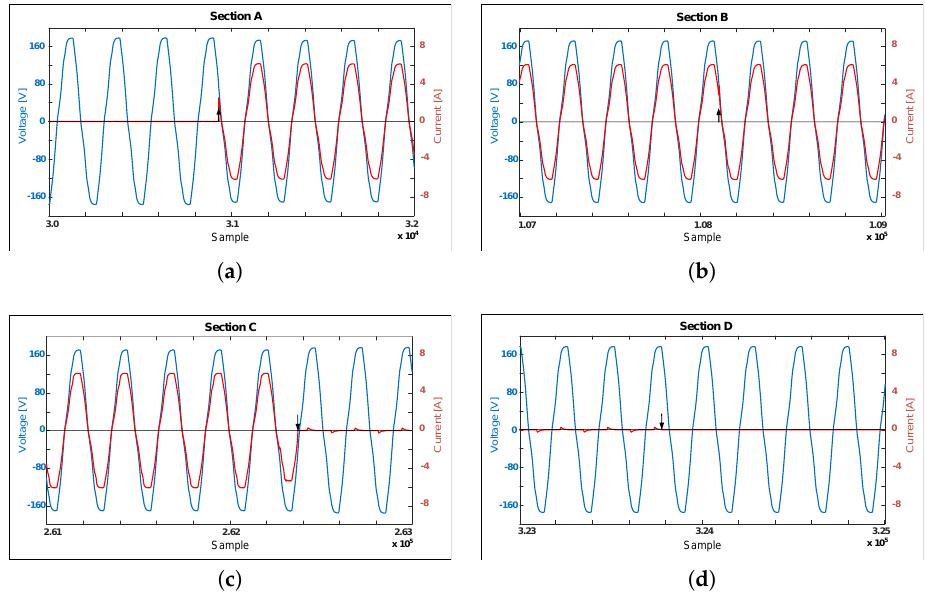
Figure 15. Jig acquisition of two loads: oil heater and LED lamp—trigger angle of 135 degrees. ( a ) Turn-ON event section A: heater turned on. ( b ) Turn-ON event section B: LED lamp turned on. ( c ) Turn-OFF event section C: heater turned off. ( d ) Turn-OFF event section D: LED lamp turned off.